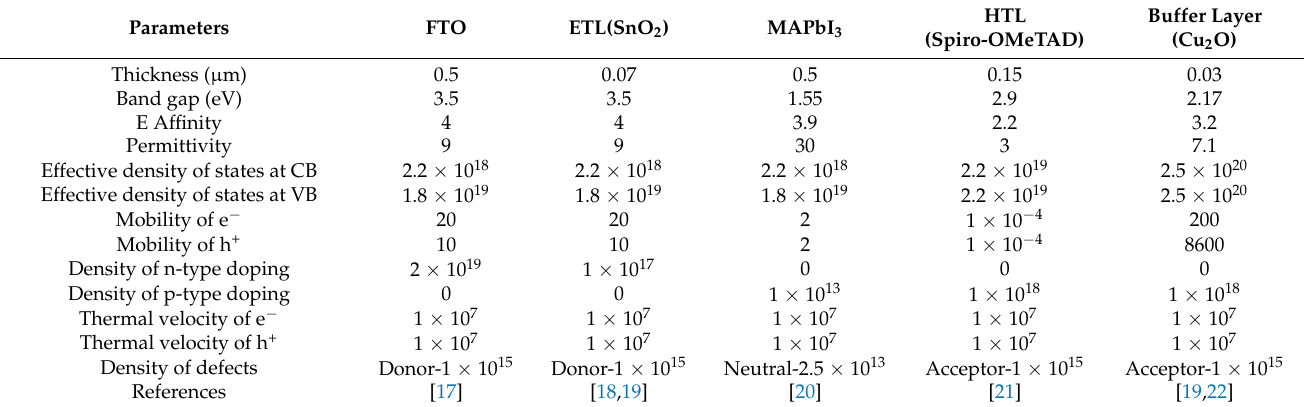
Table 1. Primary input parameters used for the simulation of perovskite solar